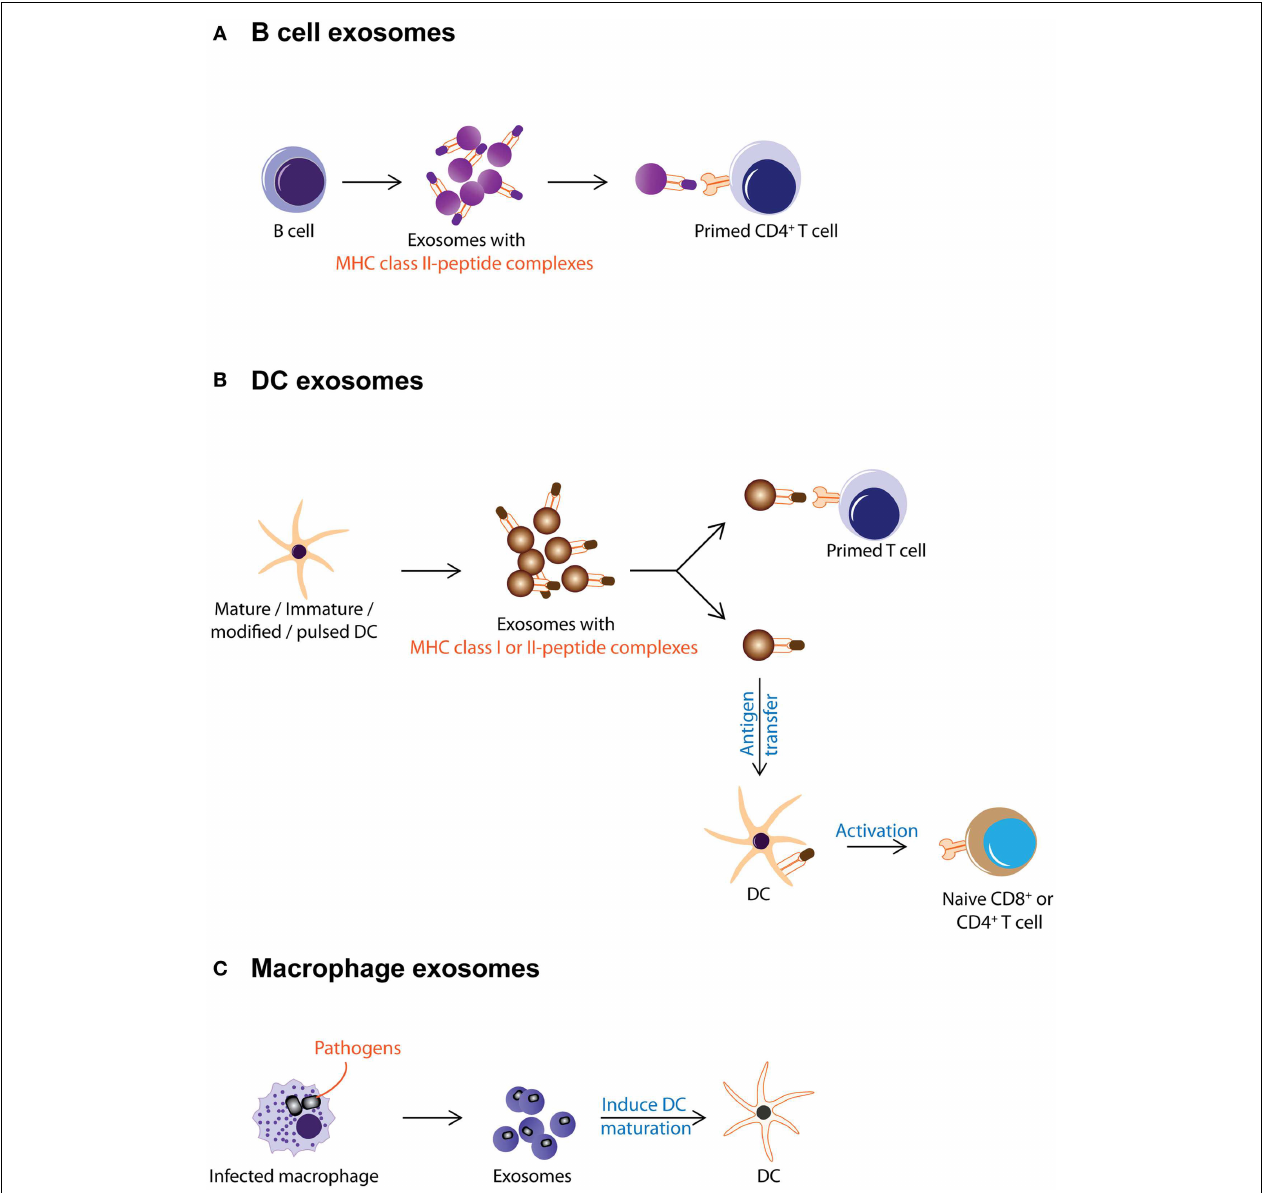
directly recognized by pre-activated CD4 + or CD8 + T cells or captured and presented by DCs to activate naïveT cells. (C) Macrophages infected with pathogens secrete exosomes with pathogen antigens.These exosomes induce maturation of DCs and promote secretion of pro-inflammatory